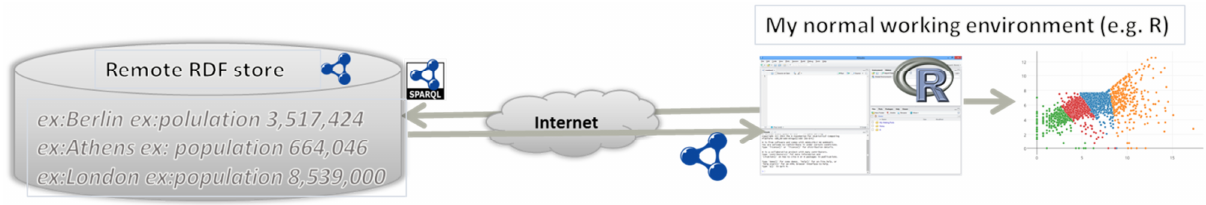
Figure 7: Accessing an RDF Store from within R